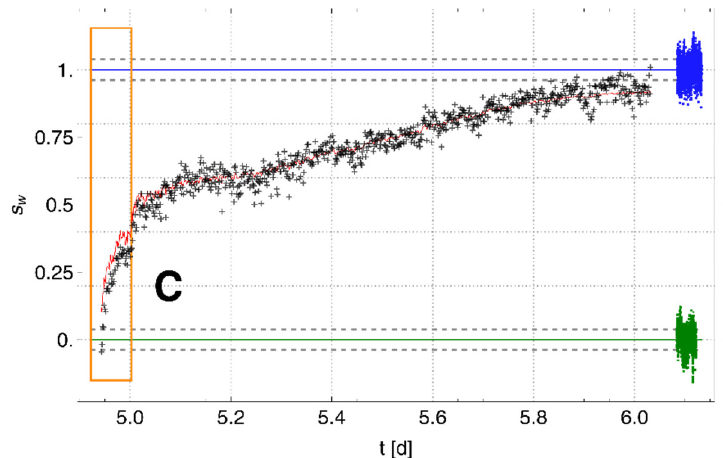
Figure 8. Increasing water saturation (black) around the membrane tube in the test container for Experiment 3. For comparison, the respective signal fluctuations for complete vapor saturation (green) and complete water saturation (blue) around the membrane are shown compressed in time on the right. Standard deviations are shown as dashed lines. The red line shows the mean evolution of water saturation. After a fast increase in saturation during watering (orange box, marked C), the slow further increase can be attributed to the comparatively slow displacement of the remaining residual air around the membrane surface by